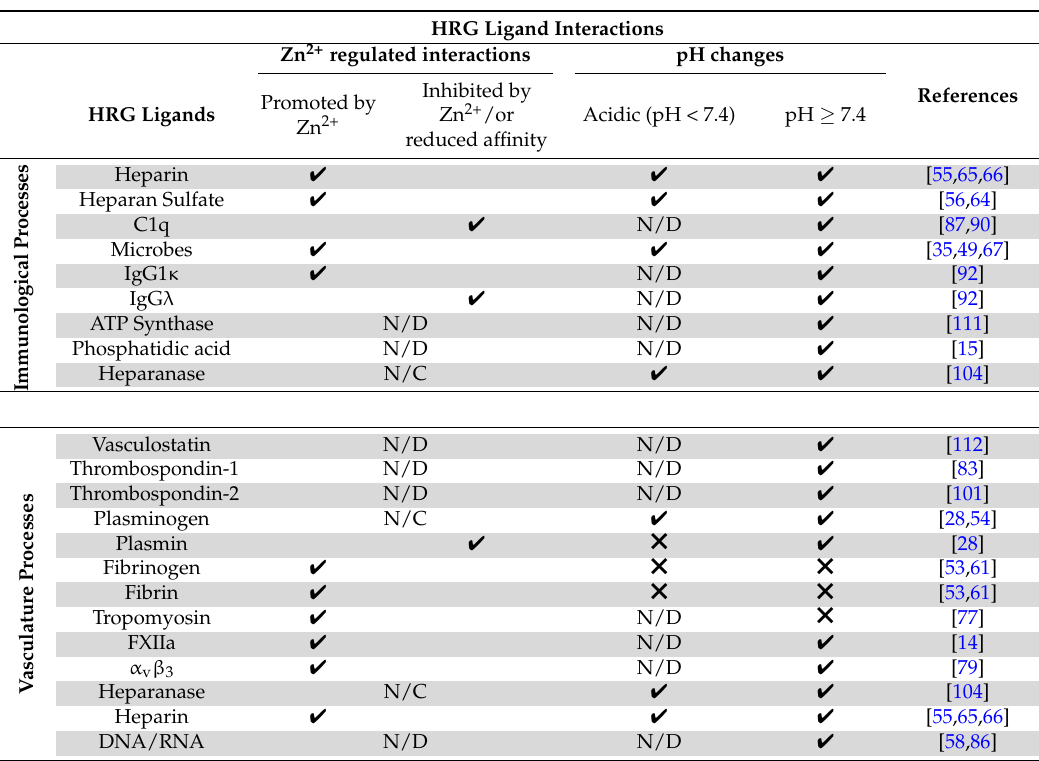
Table 1. Histidine ‐ rich glycoprotein ligand interactions that can facilitate immunological or vascular processes, with the tick ( ✔ ) denoting the type of physiological setting wherein the interaction can take place; the cross ( ✖ ) denotes which condition was tested and no interaction was observed; no change (N/C) denotes that Zn 2+ had no impact on the interaction; and not determined (N/D) denotes the interaction has not been tested.